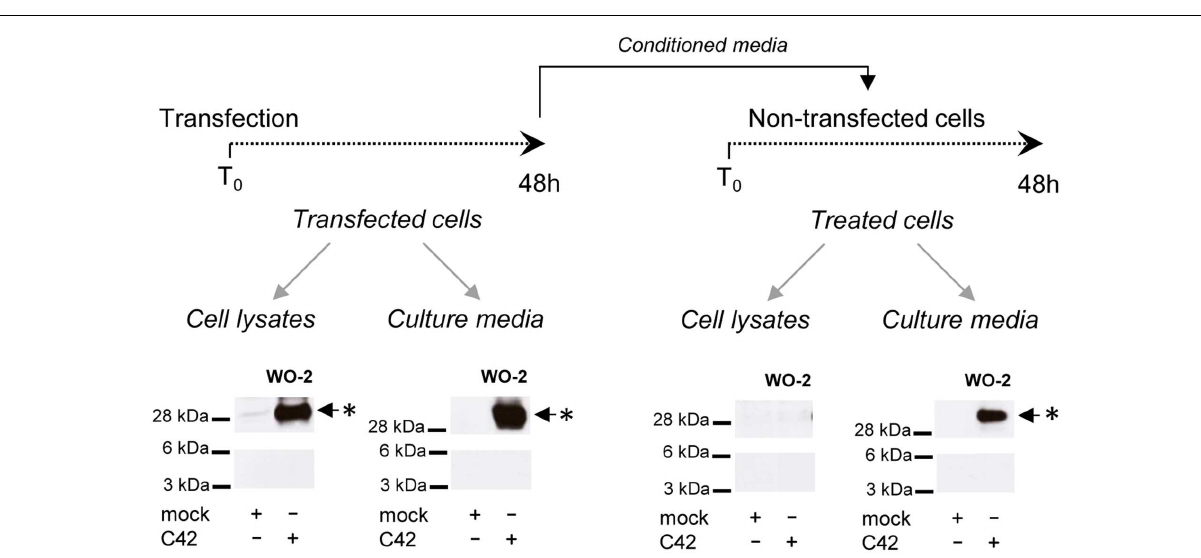
FIGURE 4 | Oligomers detected in cells and not re-captured from the culture medium. CHO cells were either transfected by the C42 construct (transfected cells) or treated (treated cells) for 48 h with the conditioned culture medium of C42-transfected cells (mock, non-transfected), as depicted on the top of the figure. The cell lysates and culture media of transfected and treated cells were recovered and analyzed by Western blotting with the W0-2 antibody. The ∼ 30 kDa oligomer band ( ∗ ) detected in cell lysates and culture media is indicated by an